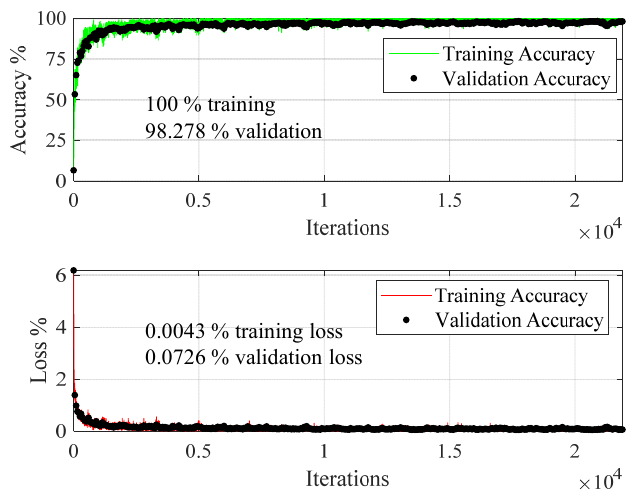
Figure 18. Training and validation results of ResNet18 on data augmented via 16 virtual sensors. (Solid line shows training, dot refers to validation).